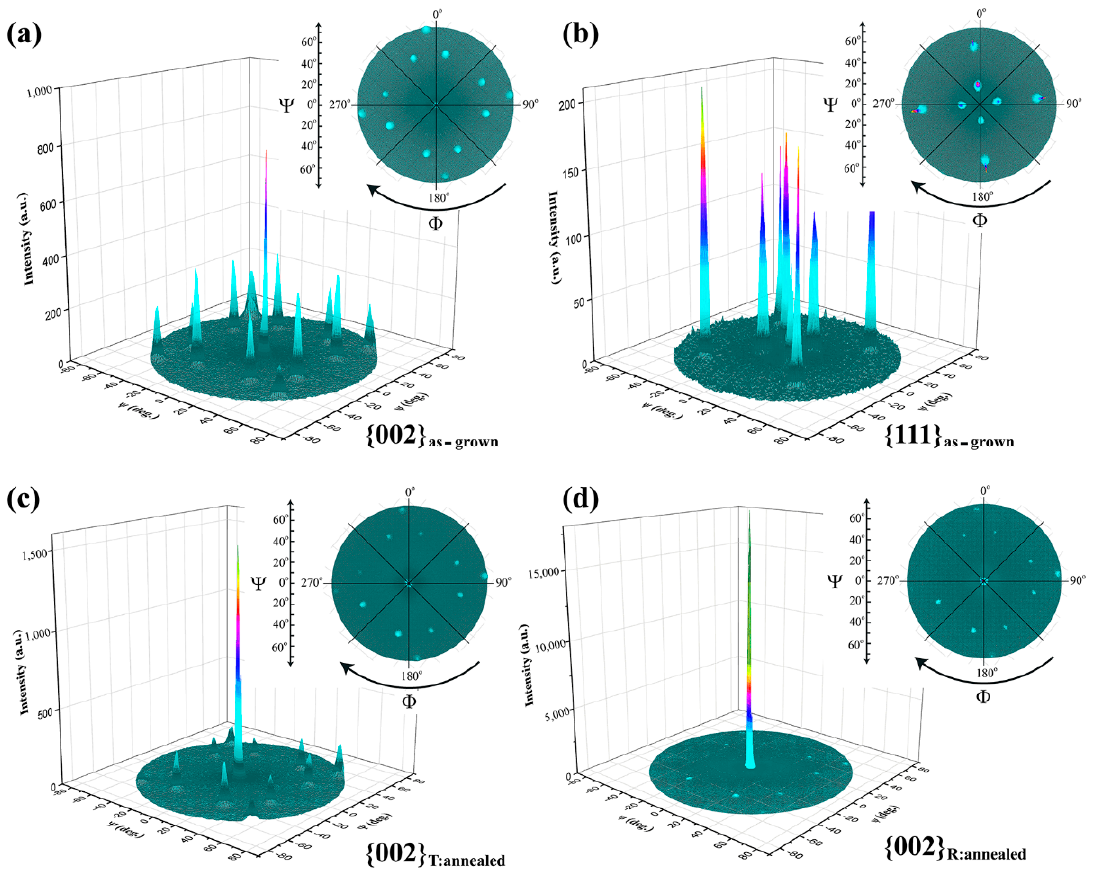
Figure 3. XRD pole figures ( a , b ) using the ( a ) {002} and ( b ) {111} diffraction peaks of the as-grown BZT film; ( c , d ) the split ( c ) {002} T and ( d ) {002} R peaks of the annealed BZT film (in 10 Pa O 2 ); (insets: top view of of ( a – d )).